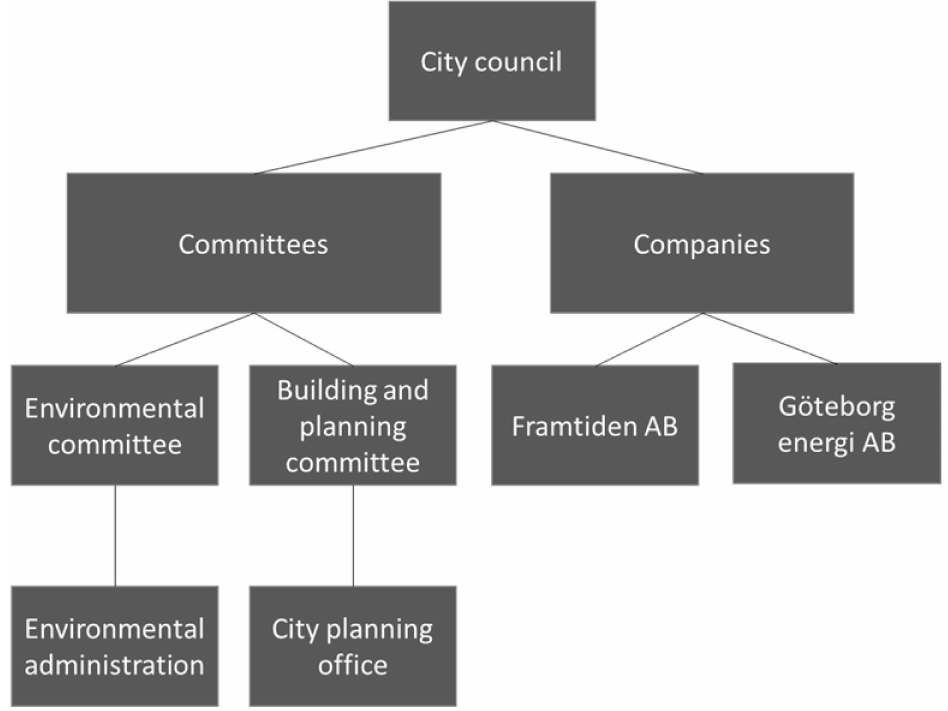
Figure 1. Main municipal stakeholders in the city of